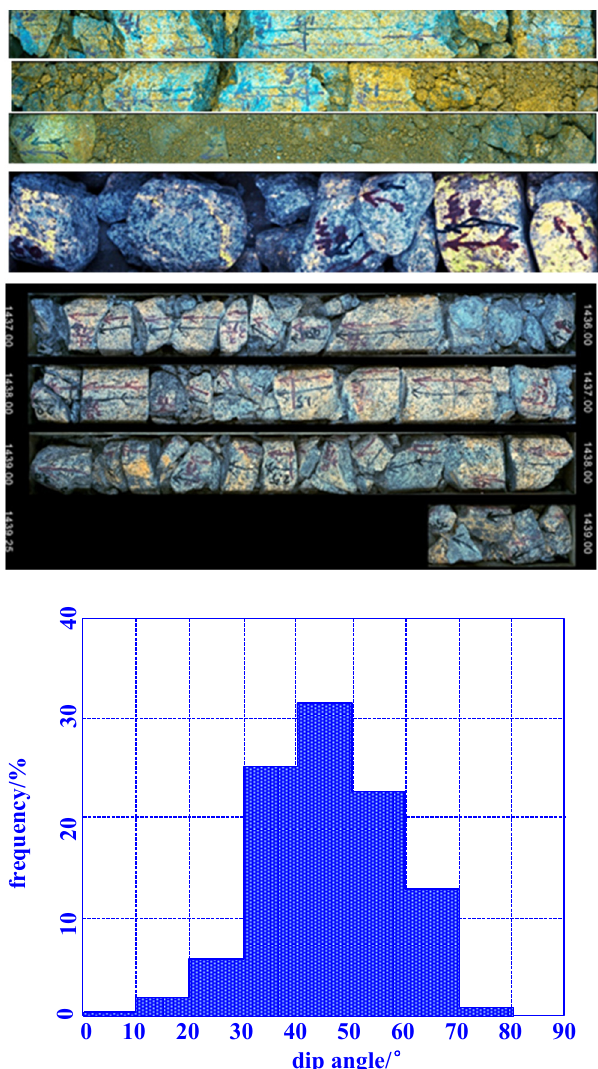
Figure 4. Core photo of the reservoir section and dip angle interpretation of imaging logging. The picture on the left is the core photo of the reservoir section of Well 2. There are 8 boxes of cores in total, and each box is 1 m long. The right figure is the interpretation result of imaging logging, which shows that medium − high angle fractures developed.